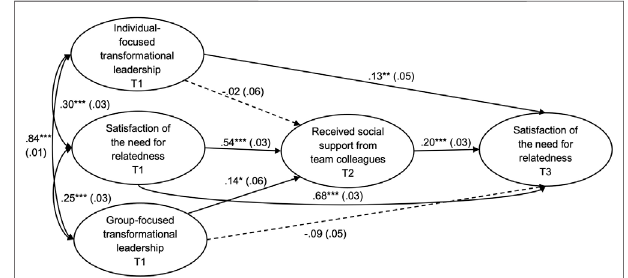
FIGURE 2 | Structural equation model with standardized estimated values of the relationship between individual- and group-focused trasformational leadership, received social support, and satisfaction of the need for relatedness with standardized regression coef fi cients. All coef fi cients are standardized, and their corresponding standard errors are in parentheses. Nonsigni fi cant paths are shown as dashed lines; N (cid:1) 1215. *** p < 0.001, ** p < 0.01, * p <